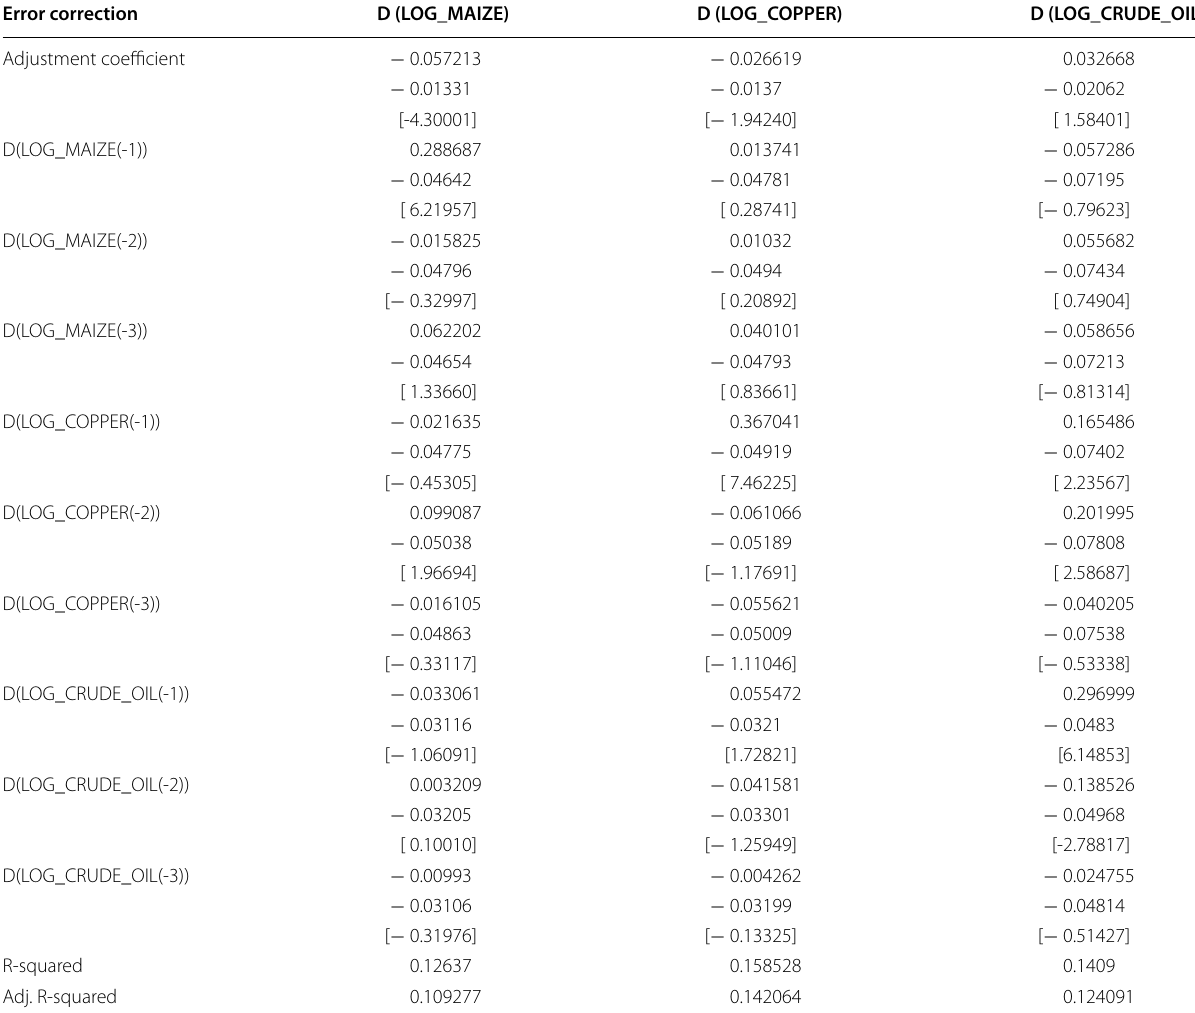
Table 10 Short run VECM